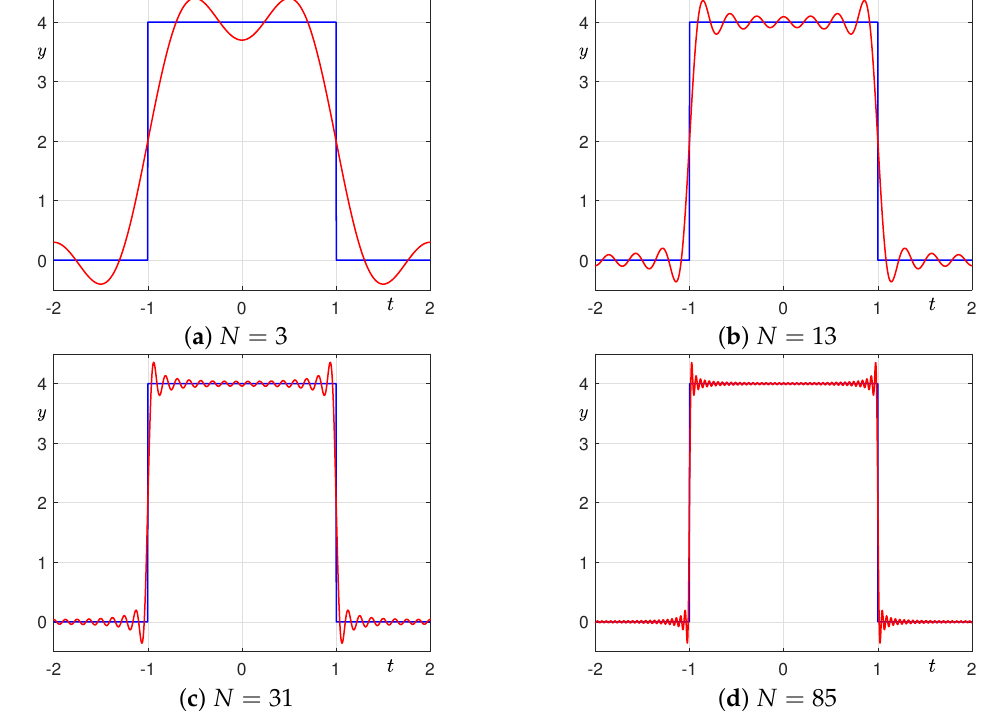
Figure 3. ( a – d ) are the Gibbs phenomena due to implement of the Fourier interpolant. Note that N denotes the number of terms in polynomial. The values are overshooted near discontinuities or sharp